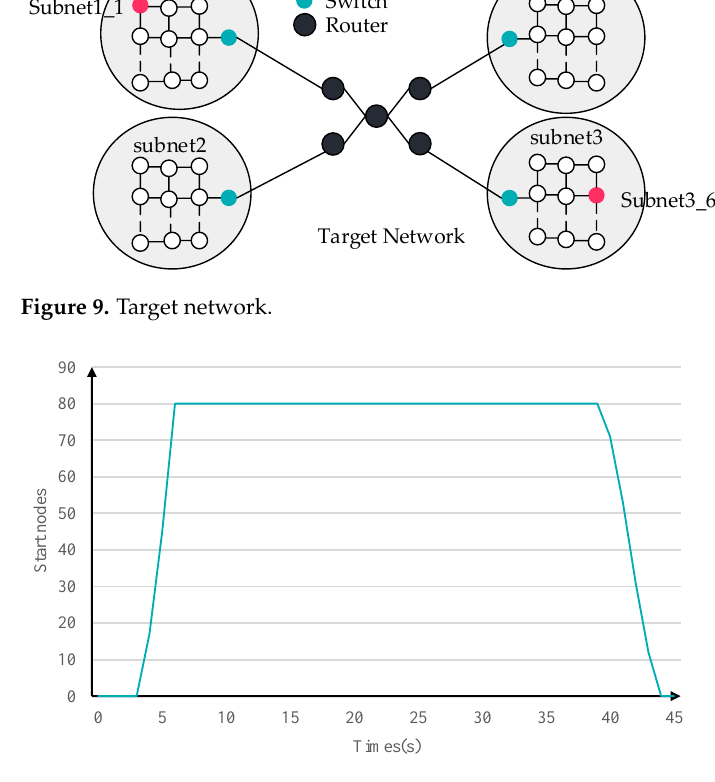
Figure 10. Online Figure 10. Online nodes. Figure 10. Online nodes.